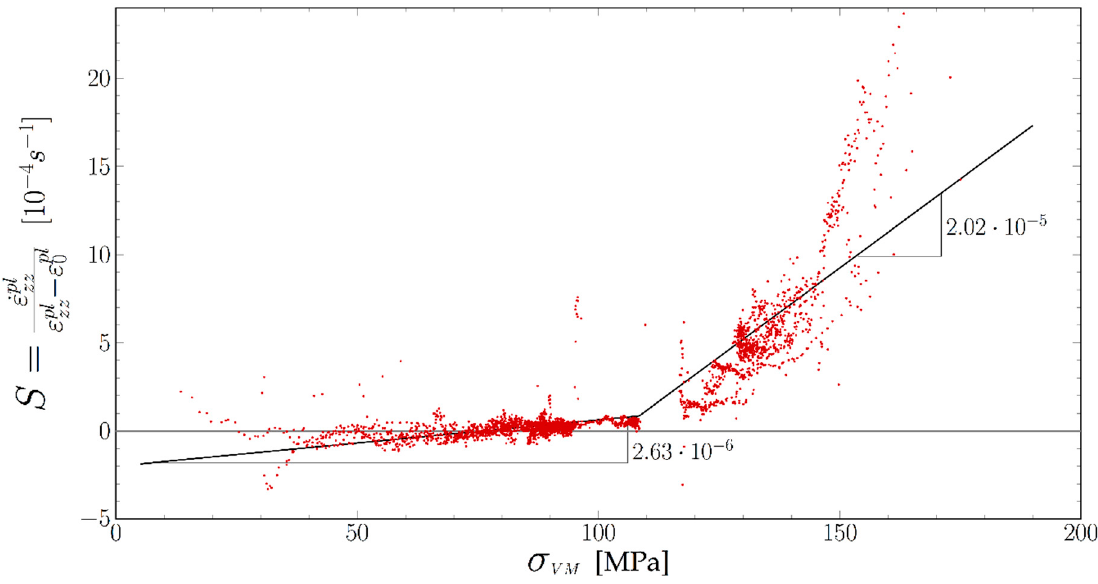
Figure 10. Strain rate divided by strain as function of Von Mises stresses.